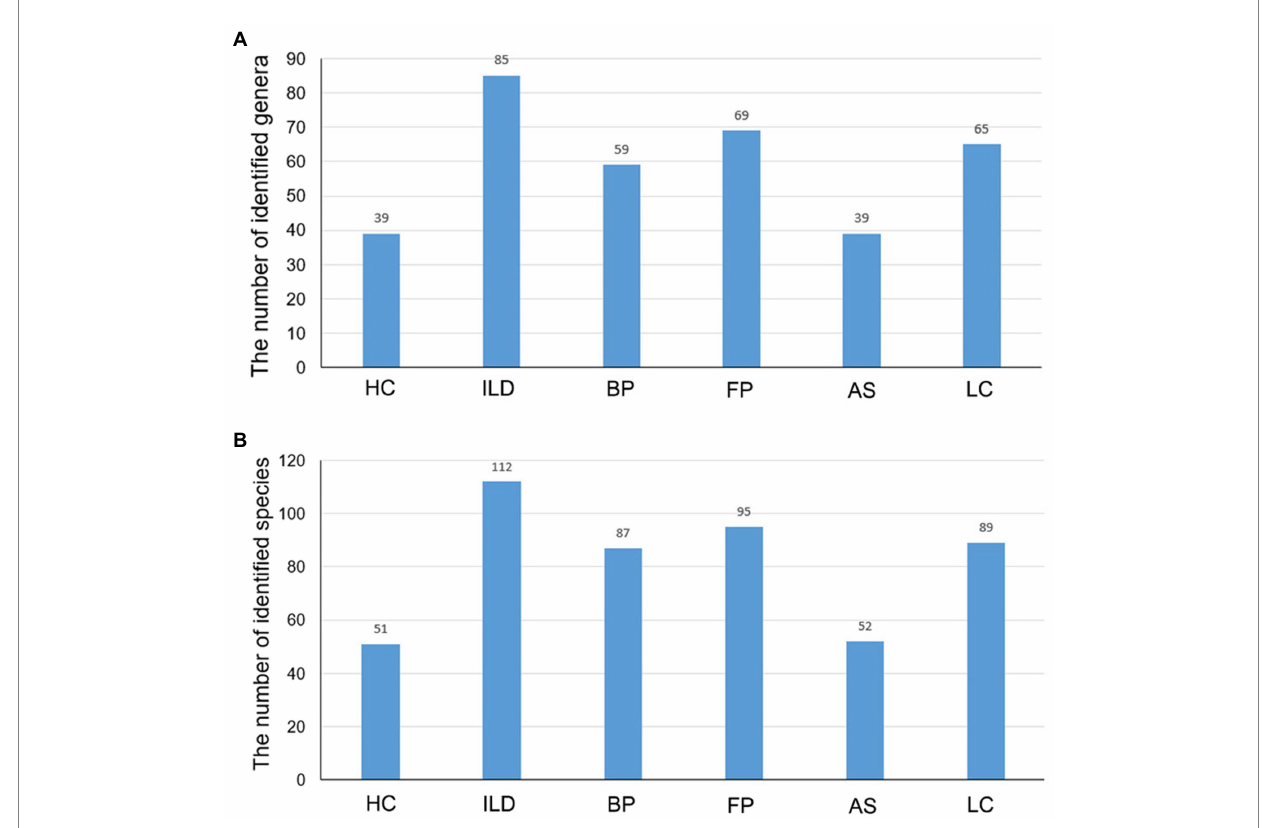
FIGURE 3 The number of identified taxa for each disease group and healthy control group. The identified (A) genera and (B) species for each